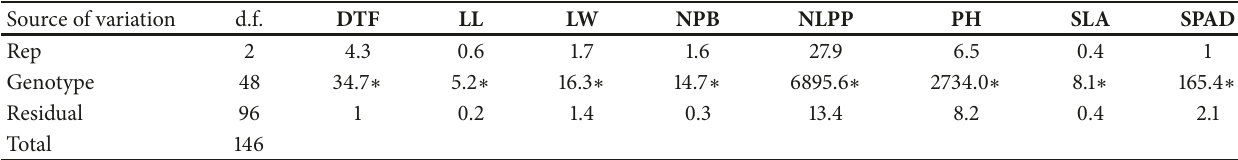
Residual 146 (b) Analyses of variance showing the mean squares for the agronomic traits in Cleome gynandra season one (October-July 2014). Source of variation d.f.